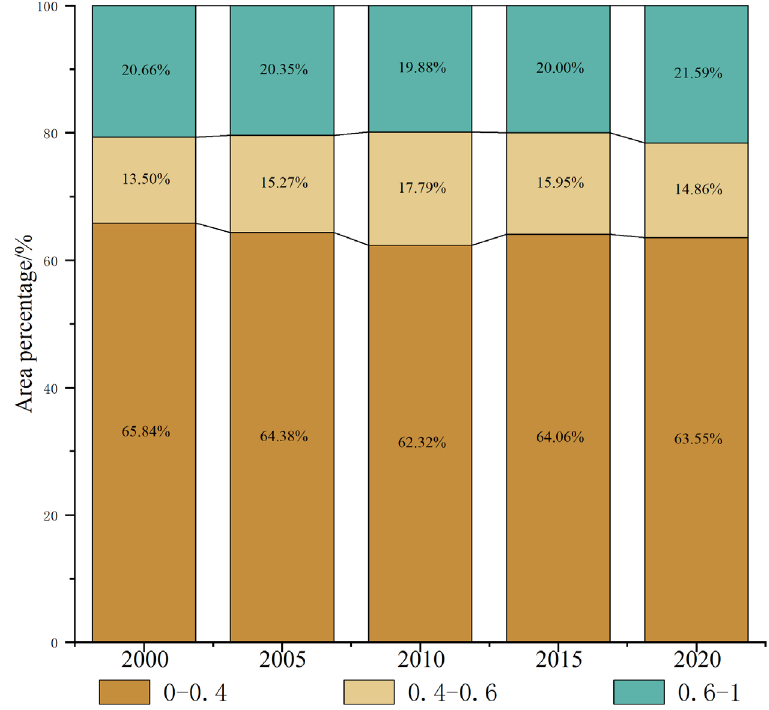
Figure 4. Vegetation cover grading chart.